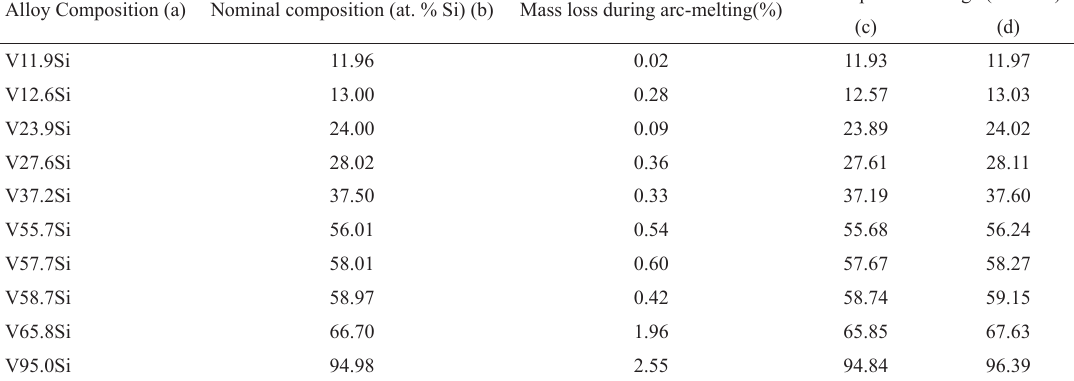
Table 2: Compositions of the alloys produced in this work. Alloy Composition (a) Nominal composition (at. % Si) (b)